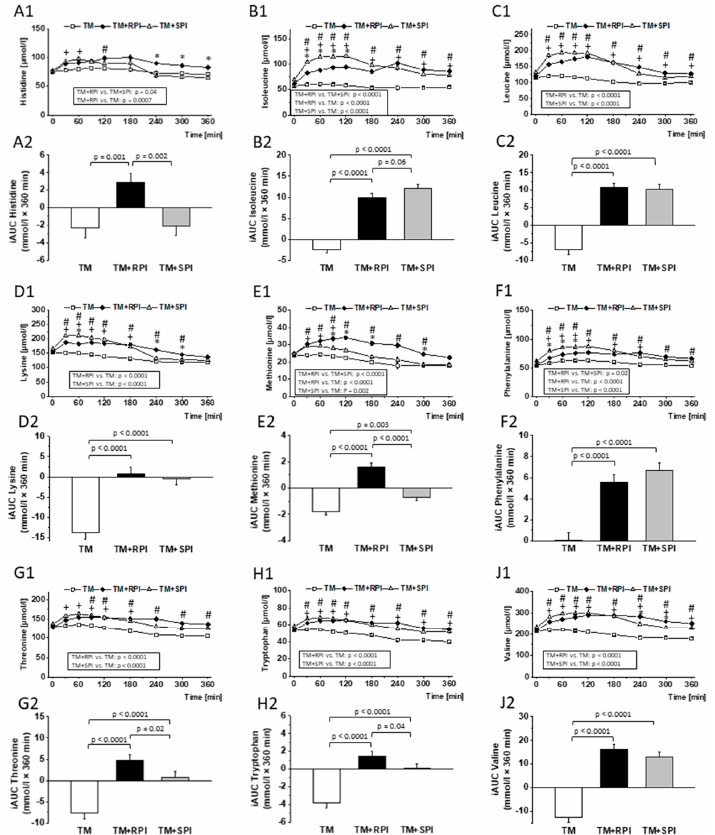
Figure 7. Postprandial response of the test meal (TM) with either no additional protein as reference ( □ ), 28 g rapeseed protein isolate (RPI) ( ♦ ), or 28 g soy protein isolate (SPI) ( ▲ ) with regard to plasma levels and incremental area under the curve (iAUC) of ( A1 , A2 ) histidine, ( B1 , B2 ) isoleucine, ( C1 , C2 ) leucine, ( D1 , D2 ) lysine, ( E1 , E2 ) methionine, ( F1 , F2 ) phenylalanine, ( G1 , G2 )threonine, ( H1 , H2 ) tryptophan, and ( J1 , J2 ) valine. Di ff erences in amino acid concentrations after the ingestion of the three test meals over 6 h were evaluated with a mixed model to test the e ff ects of treatment, time, and their interaction (treatment × time) on each parameter. The value at baseline (before treatment) was considered a covariate. The iAUC was calculated for each subject and treatment using the trapezoidal rule. The mixed-models procedure (PROC MIXED) was used for all traits. For iAUC, treatment, sex, sequence, and period were set as fixed e ff ects, and subject was included as a random e ff ect. All p values were adjusted according to the Tukey–Kramer multiple group comparison procedure. For time-point analysis, the paired t-test was applied. Significance was accepted as p < 0.05. Data are presented as LSMs ± SEs ( n = 19). # p < 0.05 TM vs. TM + RPI; + p < 0.05 TM vs. TM + SPI; * p < 0.05 TM + RPI vs. TM +